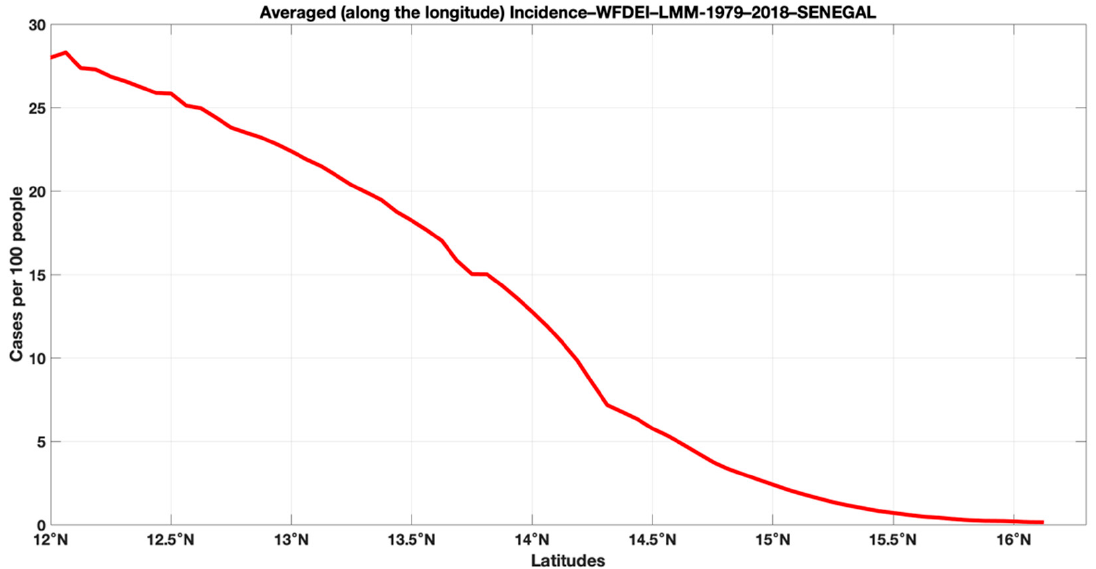
Figure 10. Latitudinal variation in malaria incidence for the period 1979–2018: LMM model simula- tions based on WFDEI data.